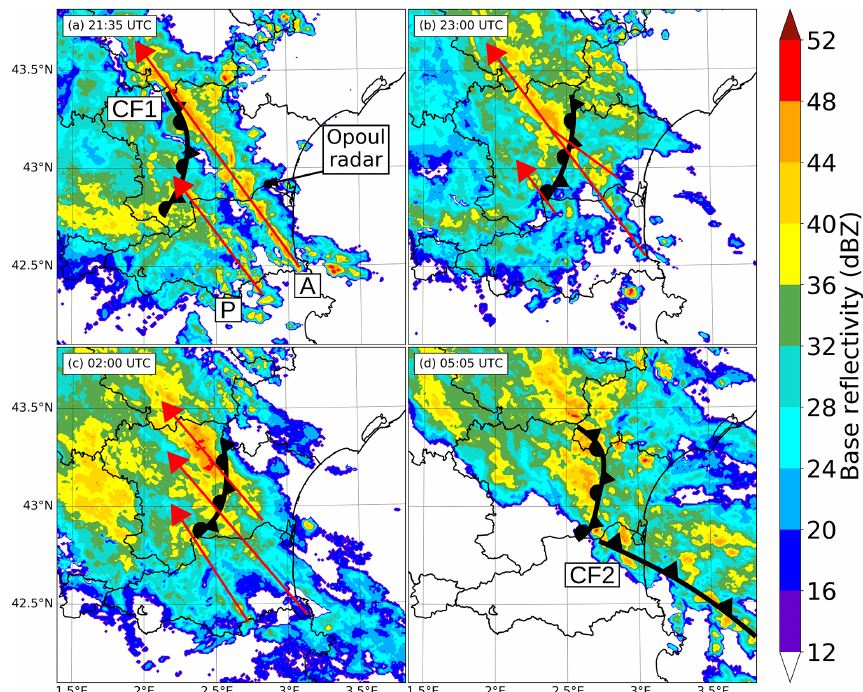
Figure 5. Radar base reflectivity from the Météo-France operational mosaic on 14 October at (a) 21:35UTC and (b) 23:00UTC and on 15 October at (c) 02:00UTC and (d) 05:05UTC. Red arrows show the axes of continuous convective cell renewal and the movement of individual cells shown by radar. “A” and “P” recall the location of the Albera Massif and the eastern slopes of the Pyrenees, respectively. Locations of CF1 and CF2 are indicated by bold black frontal